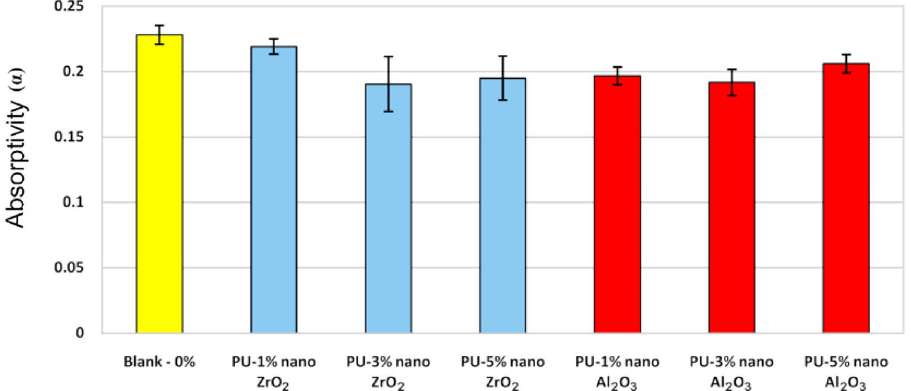
Figure 5. Absorption coefficient with standard deviation for polyurethane nanocomposite